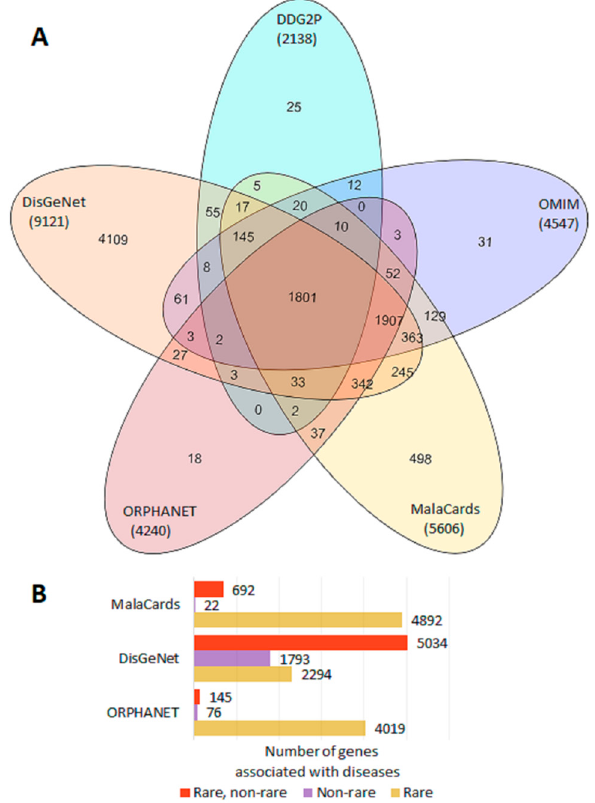
Figure 1. Representation of disease genes in gene–phenotype databases. ( A ) Venn diagram of gene sharing by OMIM, ORPHANET, DDG2P, DisGeNet, and MalaCards. ( B ) Number of genes associated with rare and non-rare diseases in ORPHANET, DisGeNet, and MalaCards.